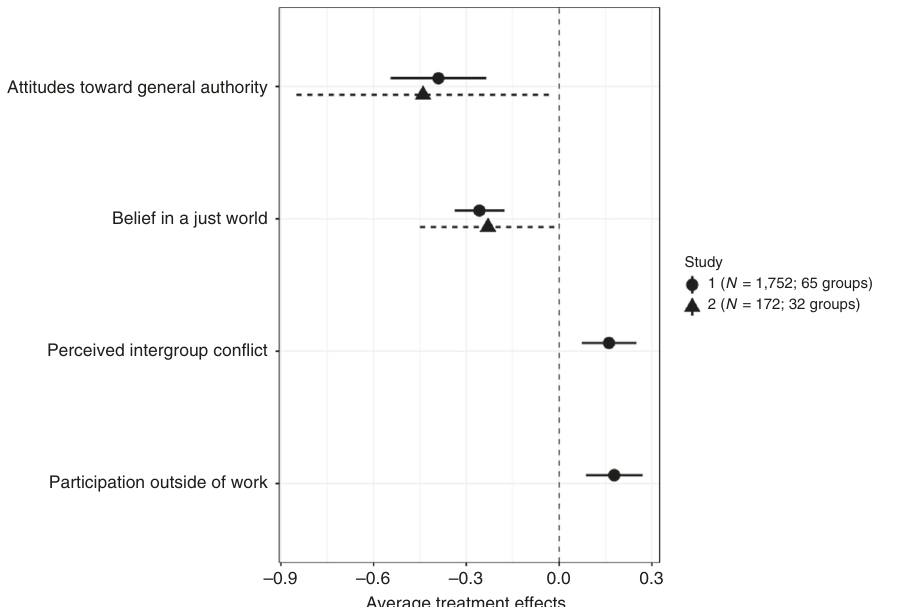
Fig. 3 Average treatment effects from participatory meetings on social outcomes. The dots indicate the estimated coef fi cients for the average treatment effect from linear regressions with fi xed effects, with robust standard error clustered on the level of groups. Error bars show 95% con fi dence intervals. Participatory meetings signi fi cantly reduced workers ’ authoritarian attitudes and belief in a just world, signi fi cantly increased perceived intergroup con fl ict between managers and workers in the Chinese society and workers ’ participation outside of